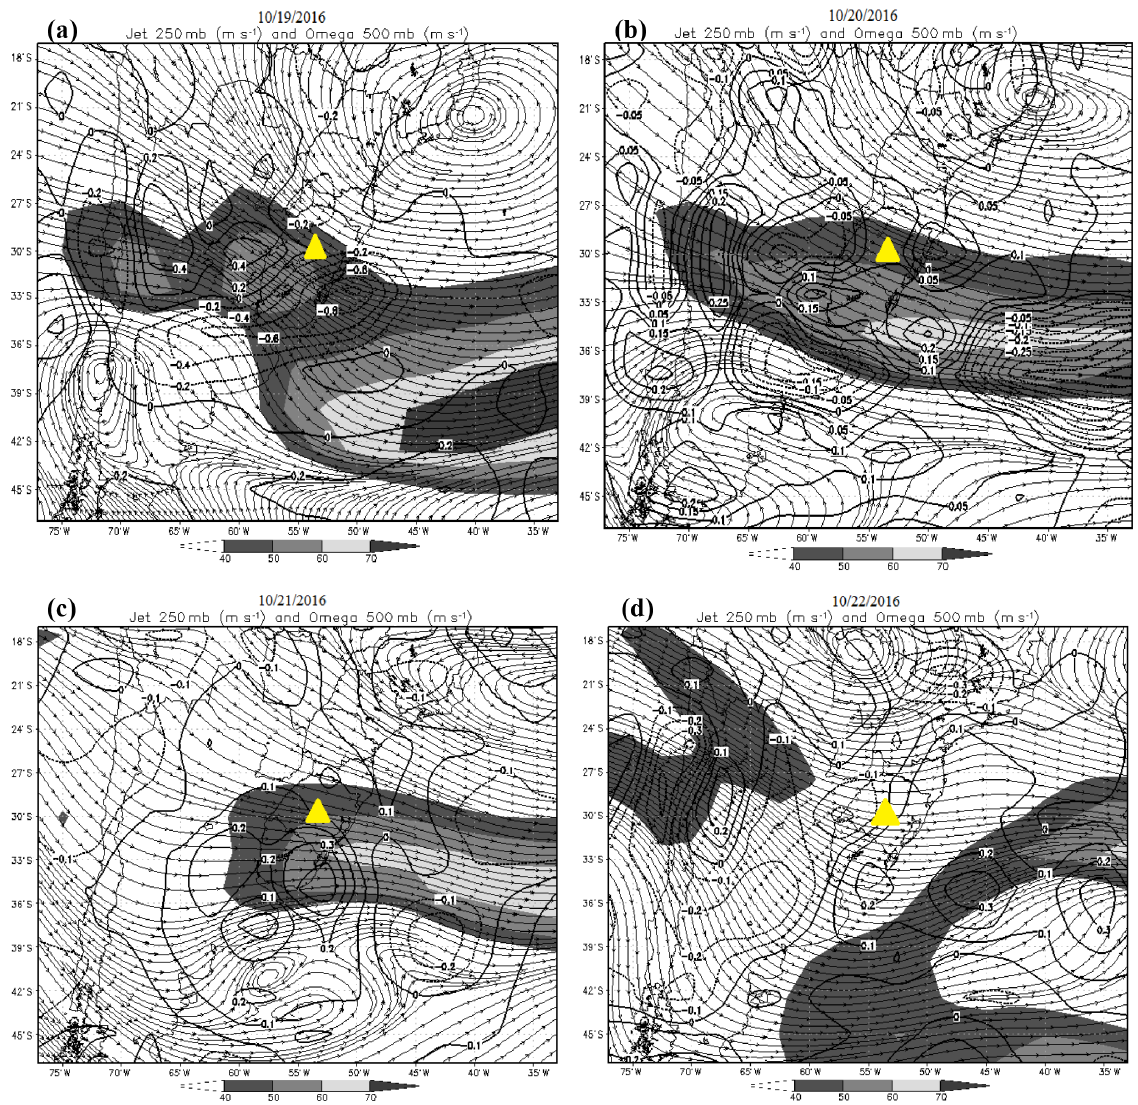
Figure 6. Horizontal cut showing jet streams at 250hPa and omega values at 500hPa. The shaded area reveals jet streams showing maximum velocity inms − 1 . The yellow triangle represents the study region.